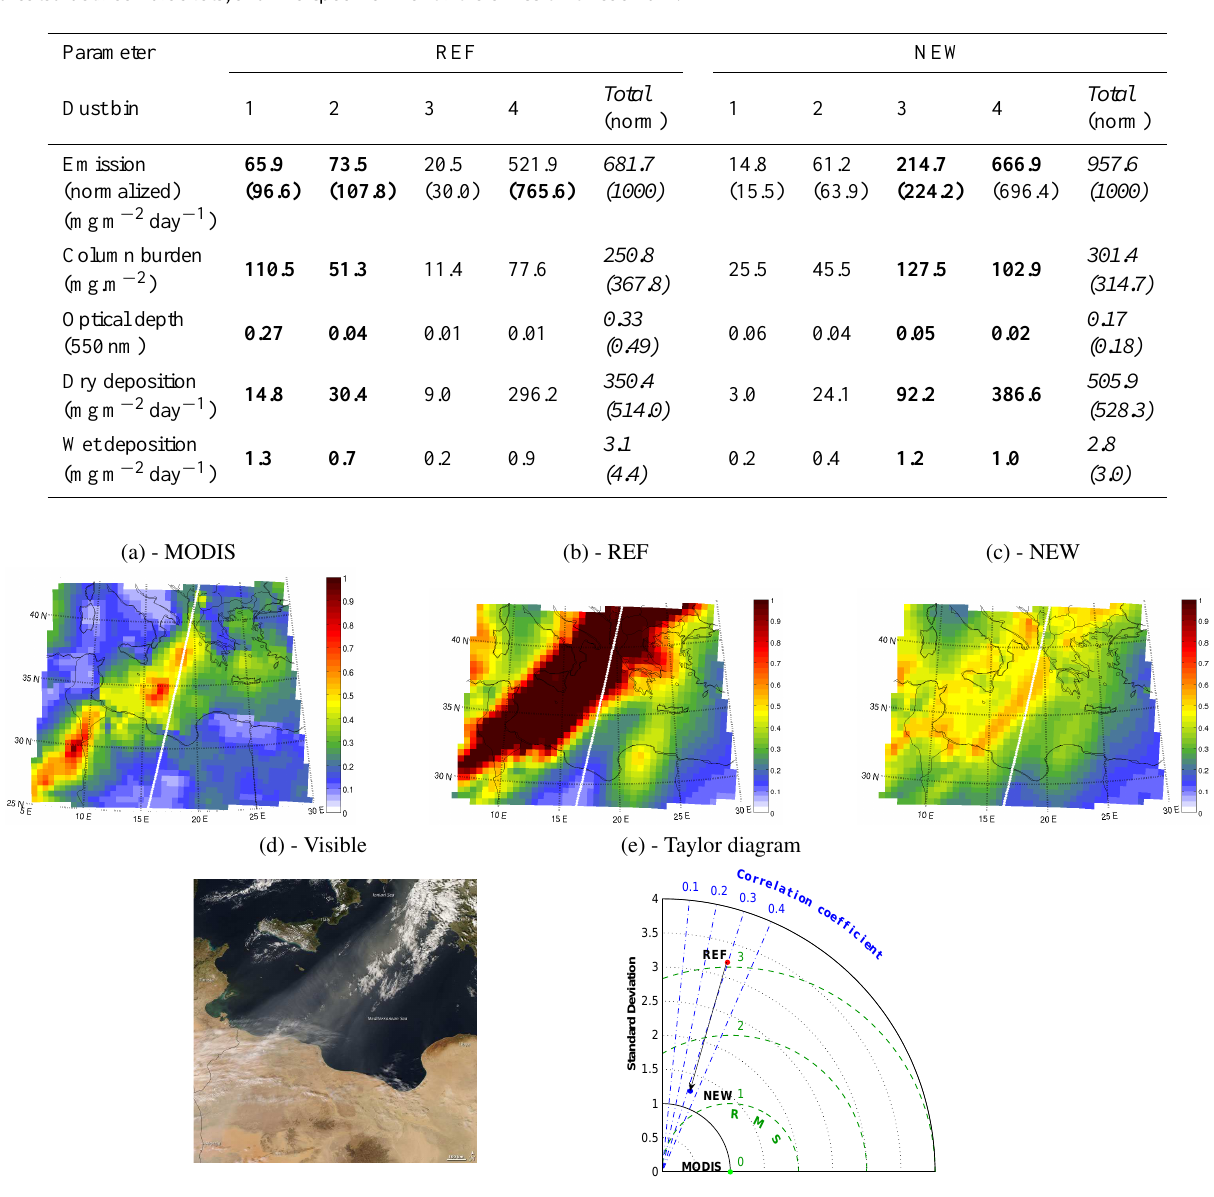
Fig. 1. Dust event between 31 October and 2 November 2008 – Comparison of aerosol optical depth (AOD) at 550nm between MODIS data (a) , REF (b) and NEW (c) . White line: the trace of CALIOP on 1 November 2008, see Fig. 2 – at the bottom: satellite image from MODIS on 1 November (d) and corresponding Taylor diagram (e)